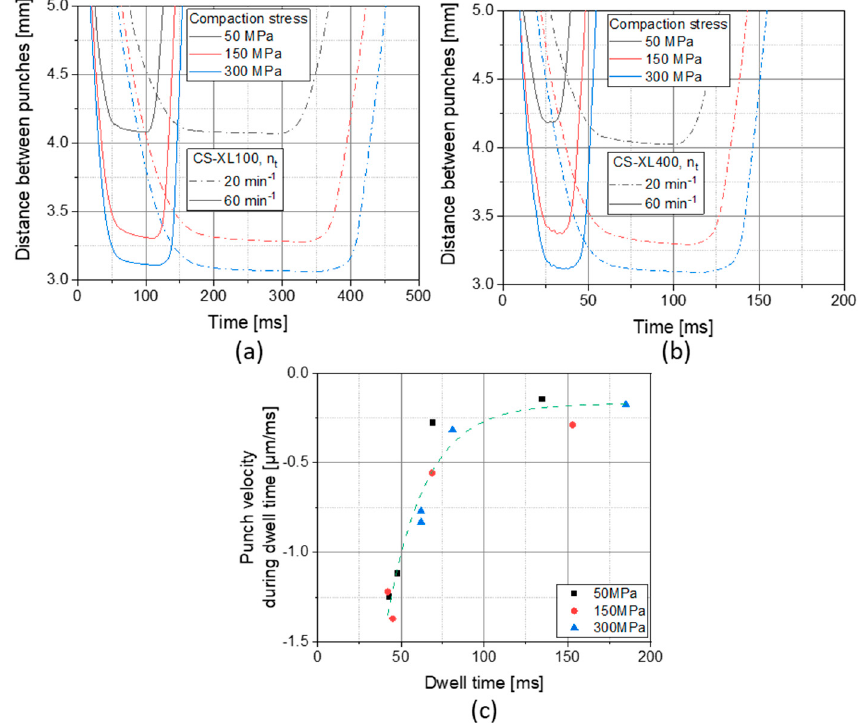
Figure 5. Effects of compaction stress, simulated turret speed and rotary press scale on the distance between punches over time profiles on the CS, simulating an XL100 at 20 and 60 min − 1 ( a ) and an XL400 at 20 and 60 min − 1 ( b ) as well as the correlation of the residual velocity of the punches during dwell time with the dwell time for the CS ( c ). All data refer to compression of starch. Negative punch velocity values indicate a further approximation of the 14 mm punches during dwell time.